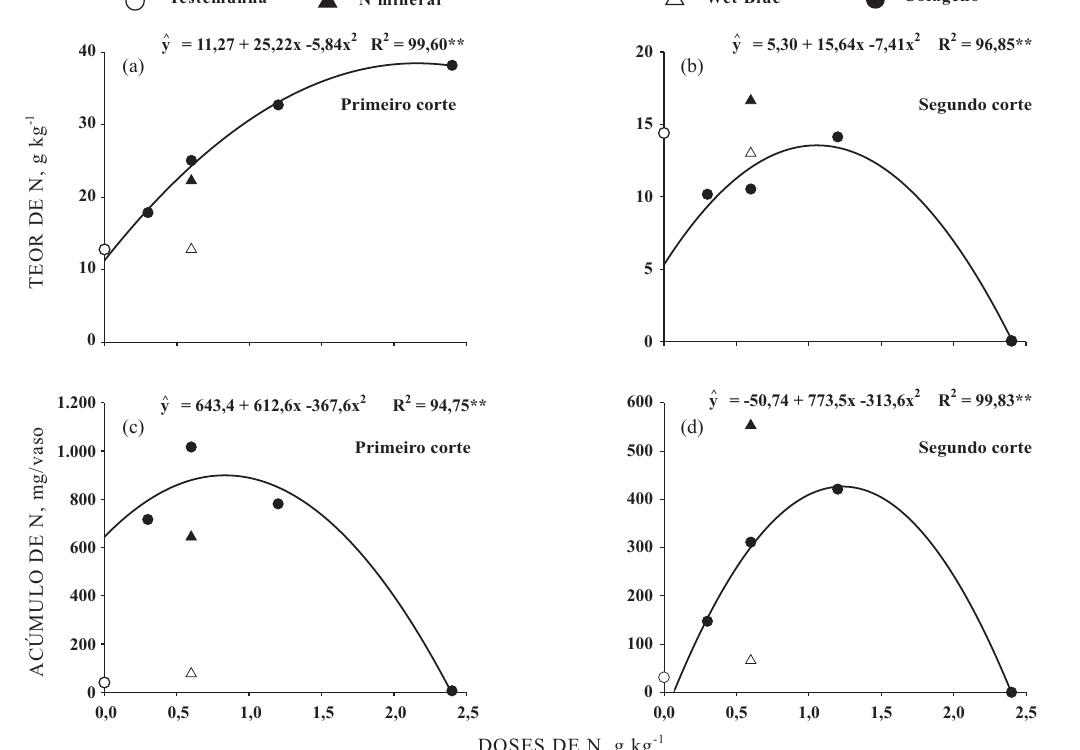
Figura 4. Teores e acúmulos de N na matéria seca da parte aérea por ocasião do primeiro (a, c) e segundo (b, d) cortes, respectivamente, em plantas de capim-elefante, com doses crescentes de colágeno e três tratamentos